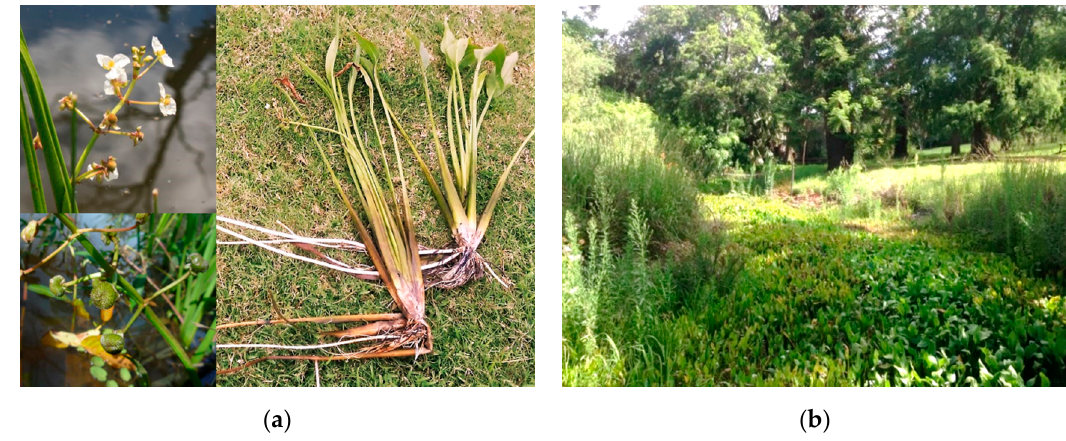
Figure 1. ( a ) Sagittaria platyphylla raceme (top left), fruit (bottom left) and whole plant showing roots system and stolons (right). ( b ) Dense monoculture of S. platyphylla choking stream in Makana Botanical Gardens, Grahamstown, Eastern Cape Province, South Africa (32.7369 S; 27.2993 E).